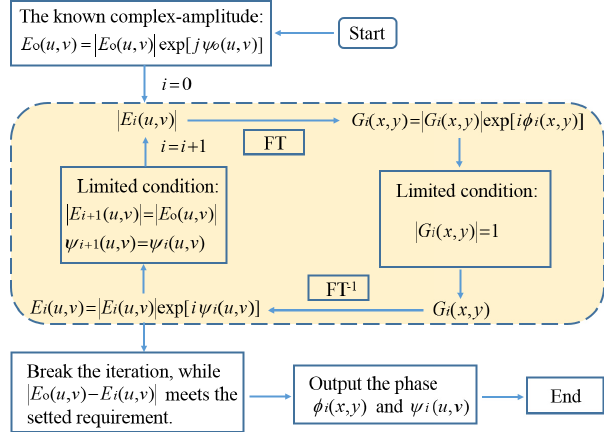
Fig. 2. Iterative process of G – S algorithm. FT and FT (cid:2) 1 represent Fourier and inverse Fourier transform separately.